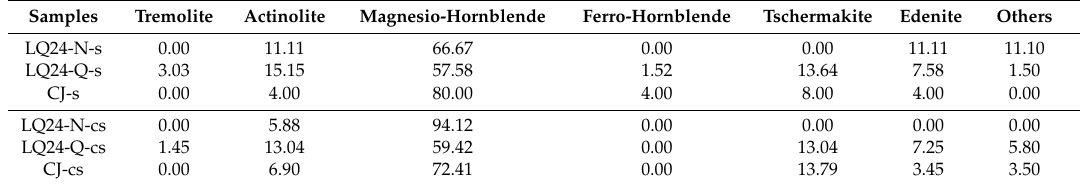
Table 2. Amphibole species (%) for Core LQ24 and the modern Changjing River. s = Very fine sand fraction (63–125 µ m), cs = coarse silt fraction (32–63 µ m). CJ = Changjiang River. Others = other amphibole species, including Ferrotschermakite, Ferroedenite, Magnesio Hastingsite, and